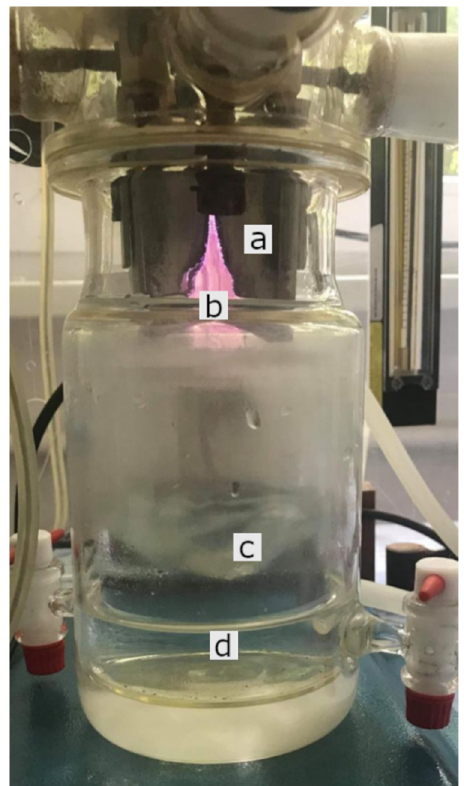
Figure 5. The plasma treatment reactor: ( a ) aluminum electrode, ( b ) plasma discharge, ( c ) plasma- water surface interaction, ( d ) PAW.